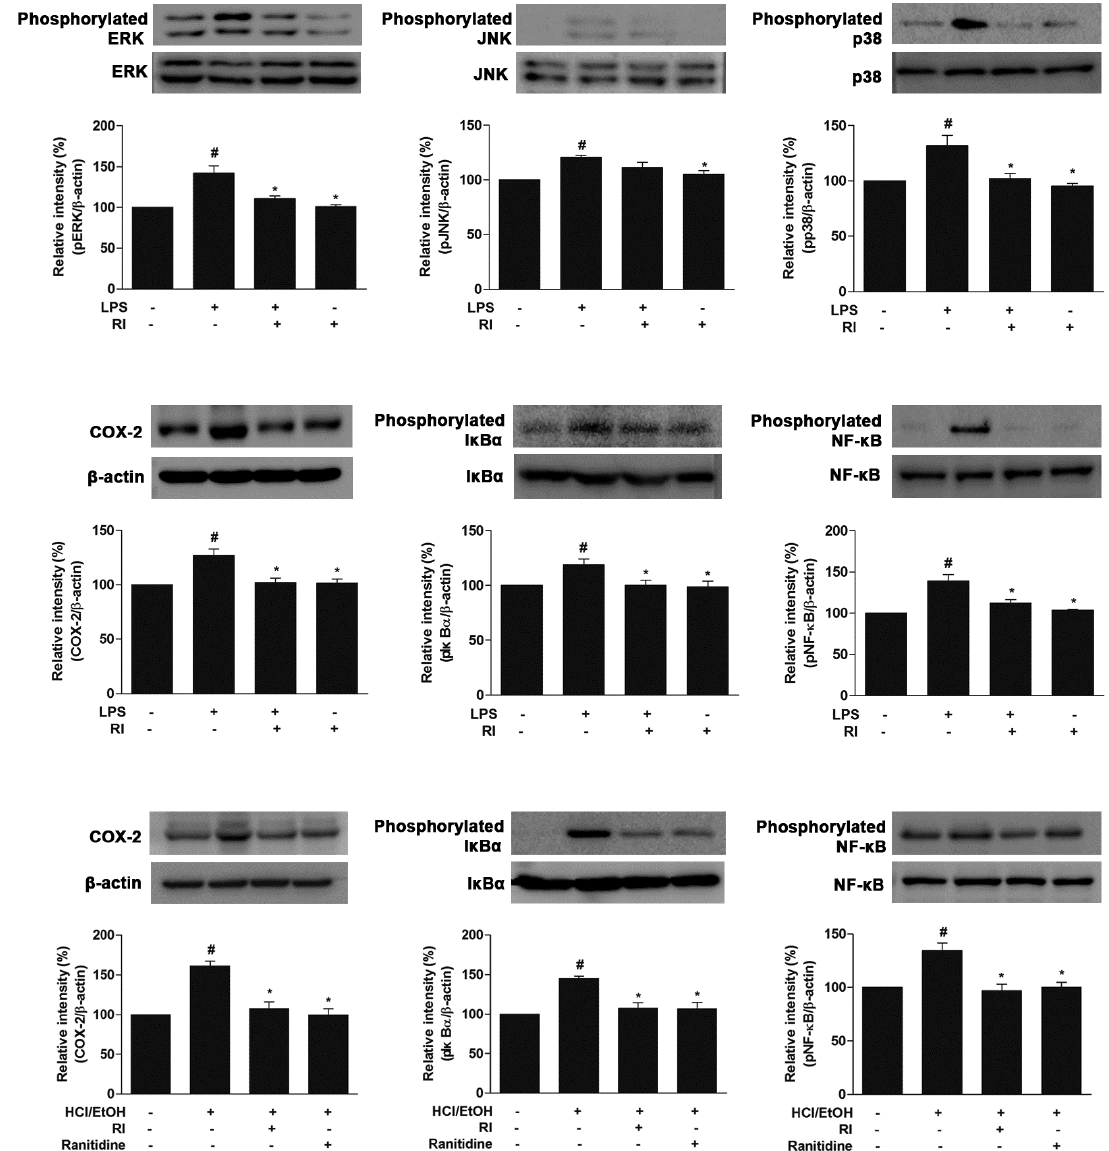
Figure 6. Protective role of RI on the MAPK cascades, COX-2 expression, and activation of I κ B α , NF- κ B in RAW 264.7 cells and gastric tissue. Here, upper and middle panels represent the MAPKs (pERK1/2, pJNK, and pp38), COX-2, I κ B α and NF- κ B expression in RAW 264.7 cells and the lower panel represents the COX-2, I κ B α and NF- κ B expression in the gastric tissue. The relative band intensity of target protein was measured as compared with β -actin. LPS-induced the phosphorylation of MAPK cascade, whereas pretreatment with the RI reduced the phosphorylation of MAPK cascade. LPS and HCl/EtOH increased the COX-2 expression, kinetic phosphorylation, and degradation of I κ B α and phosphorylation of NF- κ B. However, pretreatment with the RI notably decreased the COX-2 expression, I κ B α phosphorylation, and degradation, NF- κ B translocation as related to standard drug ranitidine. # p < 0.05 when compared with the control and * p < 0.05 when compared with LPS and HCl/EtOH. Data are expressed as mean ± SEM.